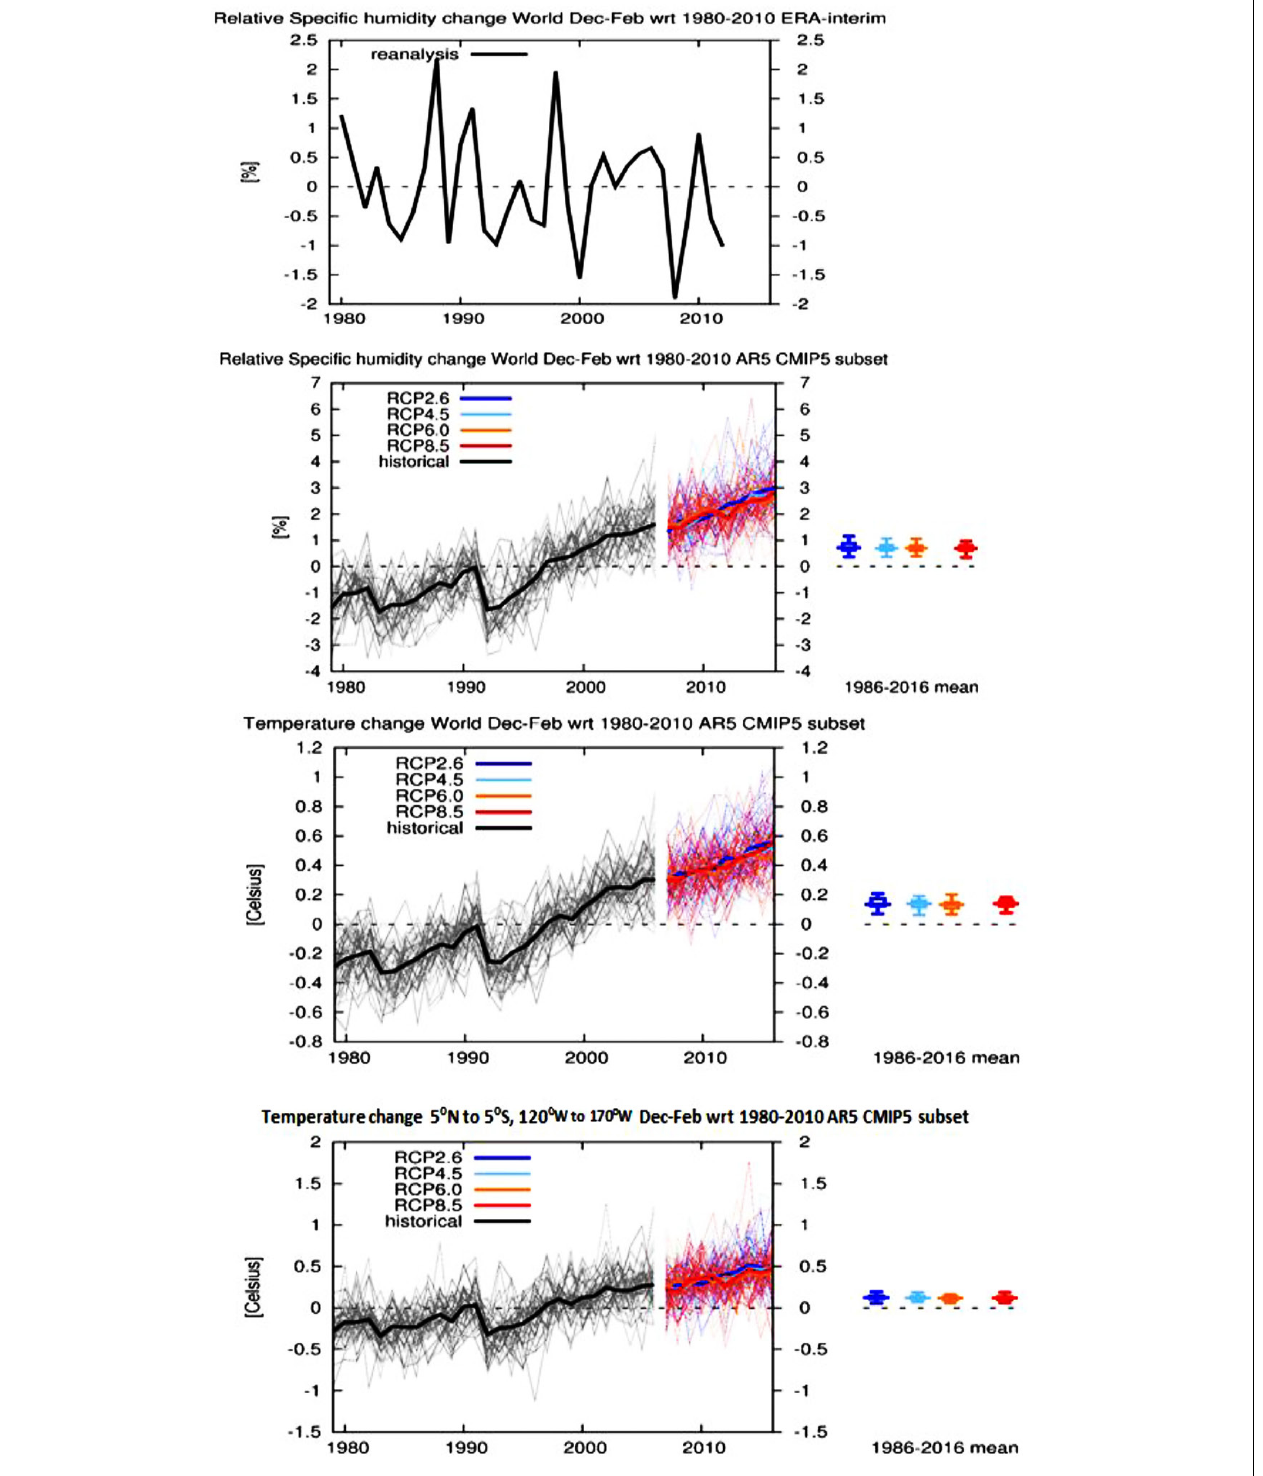
FIGURE 8 | Time series plots (Dec-Feb) of various meteorological parameters from reanalyses product (top plot) and CMIP5 models. Anomaly period considered is 1980–2010. The top plot is for specific humidity from ERA Interim, and the rest three are from AR5 CMIP5 subset models for global specific humidity, global temperature and near-surface temperature in Niño 3.4 region, respectively. For models, one line per model is shown by thin lines, while multi-model mean is marked by a thick line. On the right, the spread associated with various RCP scenarios over 1986–2016 are shown. Horizontal line denotes the median (50%) of the whole dataset, the box extends from 25 to 75% and the whiskers from 5 to 95%. White mark within the plots of model results indicates the start of RCP scenarios. Plots are generated using the IPCC’s Climate Change Atlas; climexp.knmi.nl/plot _atlas_form.py.